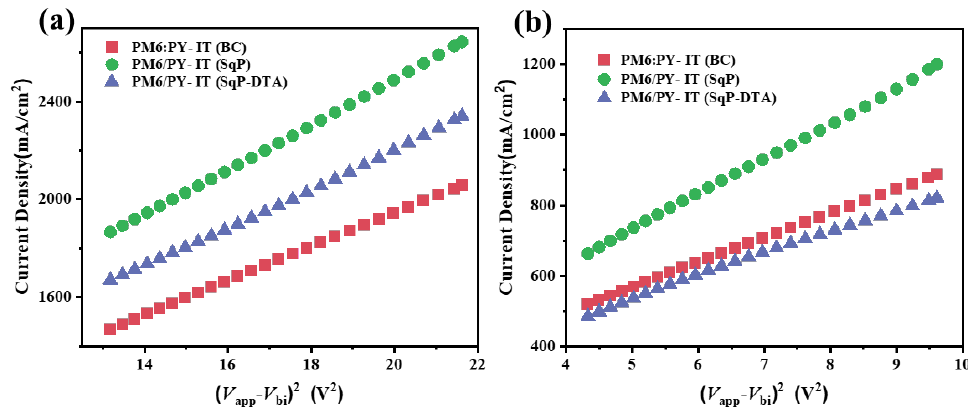
Figure 4. J ‐ V 2 curves of hole ‐ only devices ( a ) and electron ‐ only devices ( b ) for SCLC mobility calcu- Figure 4. J - V 2 curves of hole-only devices ( a ) and electron-only devices ( b ) for SCLC mobility lation.